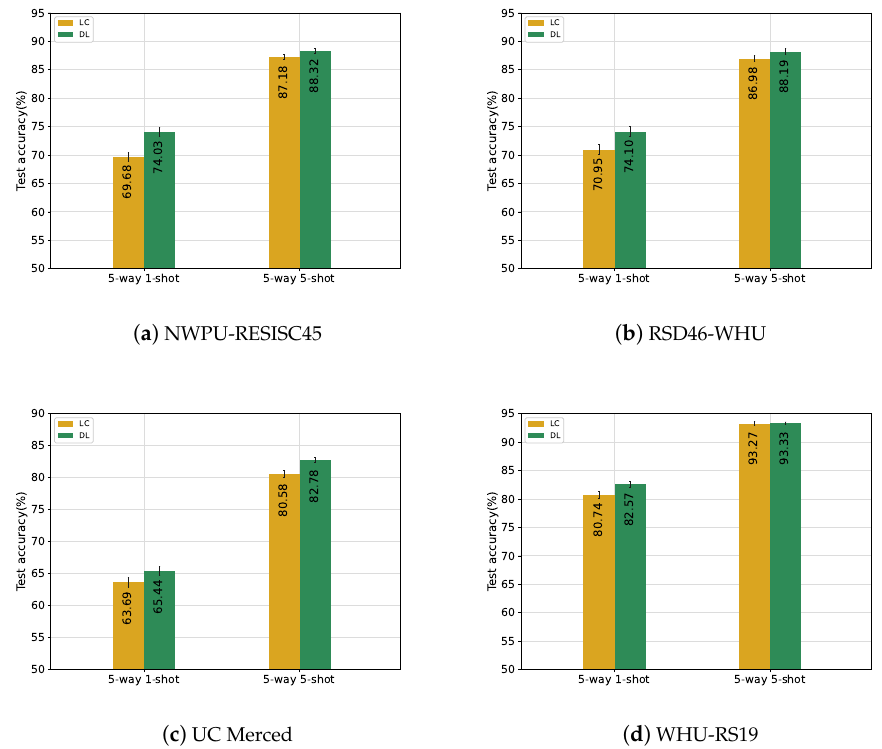
Figure 7. The influence of objective function reconstruction